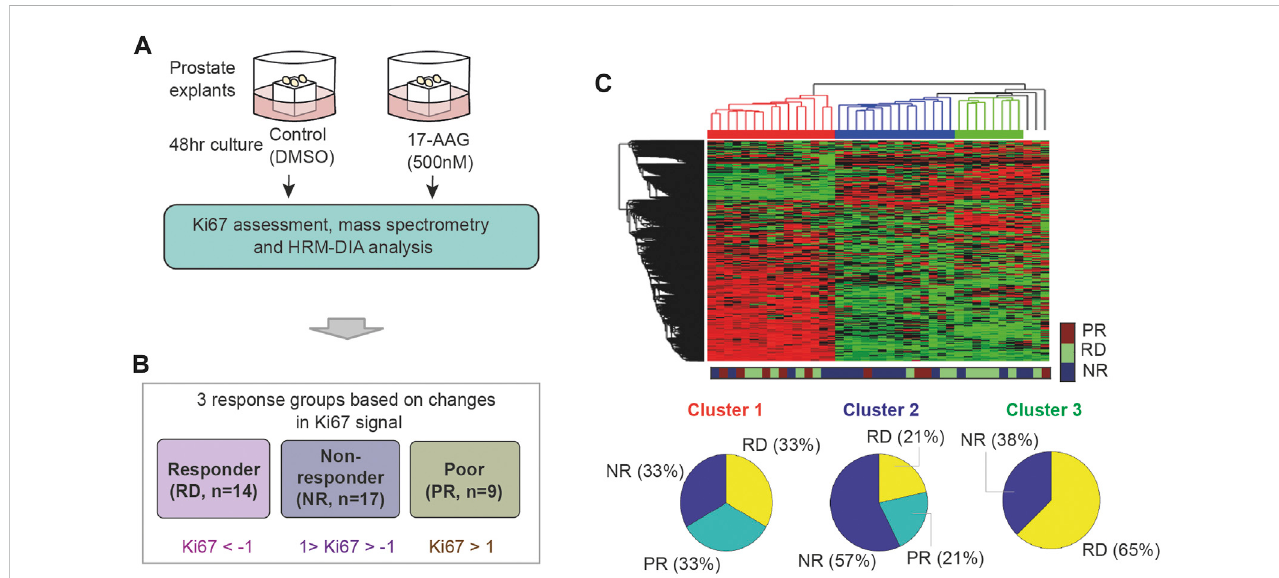
FIGURE 2 UnsupervisedclusteringofthePDEs ’ responseto17-AAGtreatment. (A) Pharmacoproteomicdataobtainedfrom40prostatecancerPDEs(Nguyenetal., 2018). (B) Classi fi cationofthePDEs into three responsegroups based onKi67 positivity post17-AAGtreatment: RD, PR,and NR withindicatedfold-changein Ki67 positivity (in log2 scale). (C) Unsupervised hierarchical clustering of the PDEs using the proteomic data, which failed to reasonably predict response to